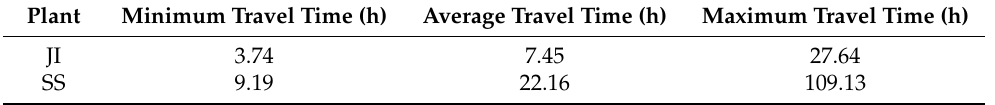
Table 2. Average, and simulated low flow (maximum), and high flow (minimum) travel times in hours in JI and SS WWTPs. The data were compiled using the length of each pipe, and the average velocity from 33 metered sites across 39 legs in the MMSD sewer